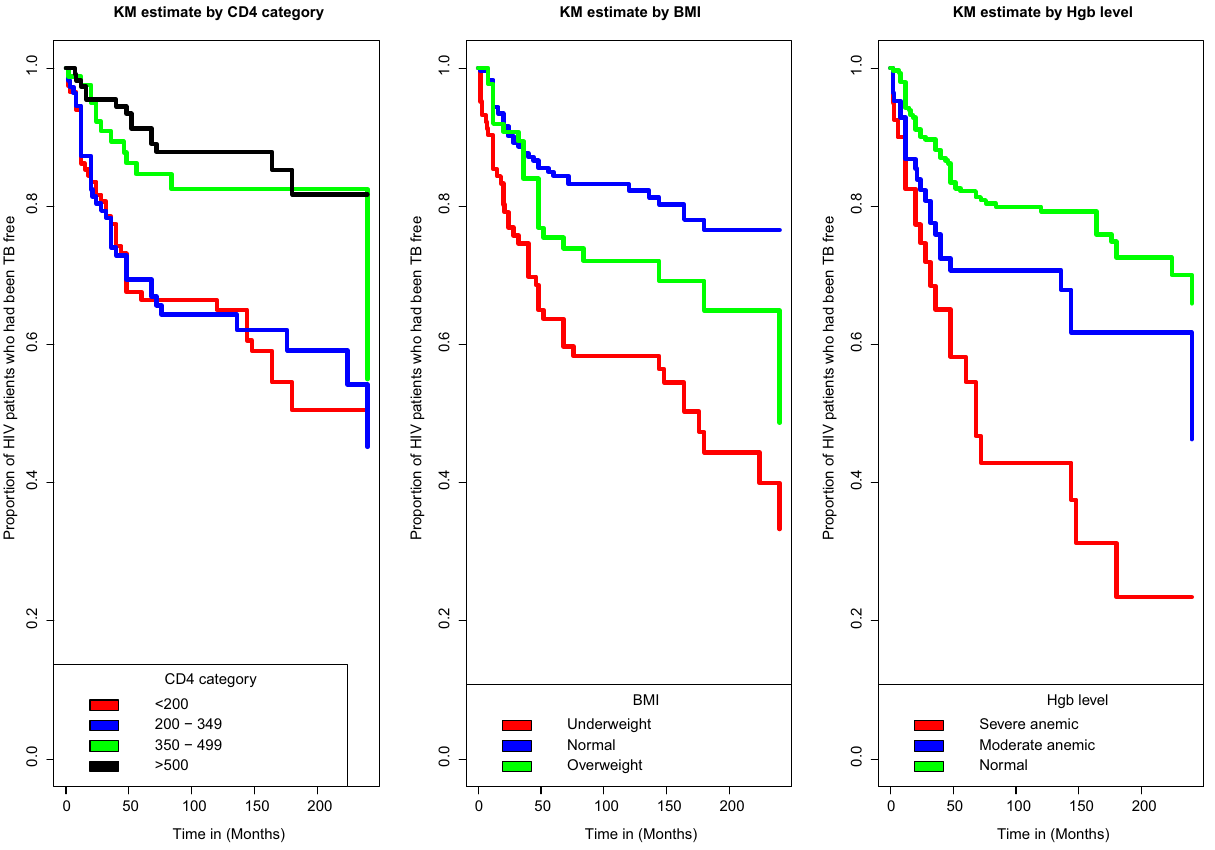
Figure 5. Kaplan-Meier survival curves for TB free co-infection survival time of patients by CD4 category, BMI and Hemoglobin level of patients.